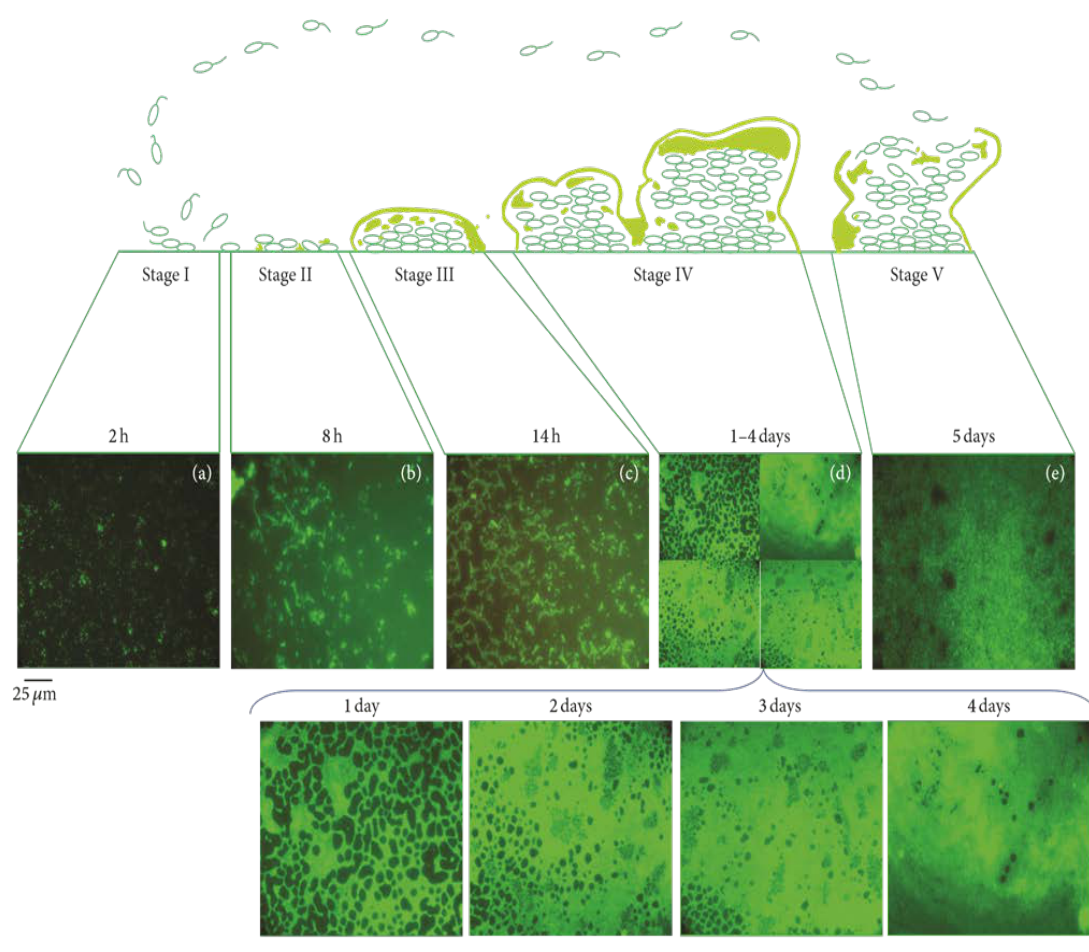
Figure 1. Schematic of the lifecycle of P. aeruginosa grown in glucose media. Images of inverted fluorescence microscopy with 400 × magnification present stages of biofilm development. In stage I, planktonic bacteria attach to a solid surface. In stage II, the attachment becomes irreversible. Stage III elucidates the microcolony foundation. Stage IV illustrates the biofilm maturation and growth of the three-dimensional bacterial sanctuaries. In stage V, dispersion occurs and free planktonic cells are released from the cluster biofilm to colonize new locations. Images characterize a 250 × 250 µm 2 field. Reproduced from [51].